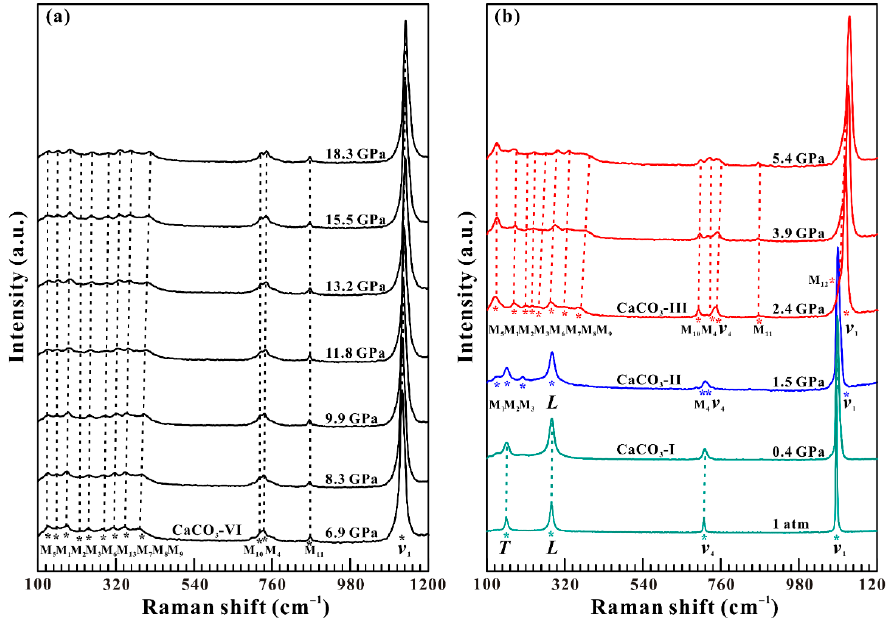
Figure 4. Raman scattering spectra of calcite upon decompression at the atmospheric temperature.